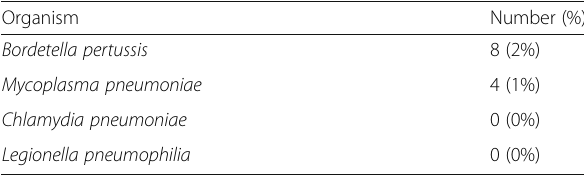
Table 1 Demographic and clinical characteristics of children Table 2 The frequency of pathogen detection using the